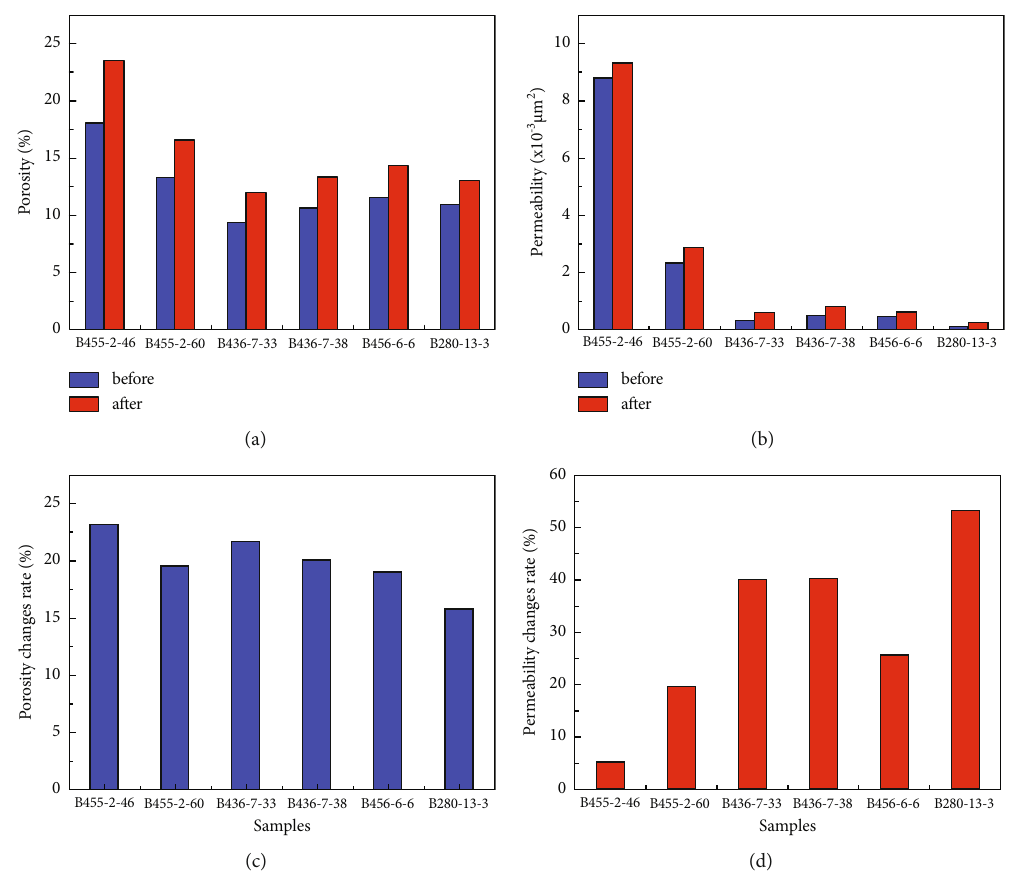
Figure 7: Changes of reservoir porosity and permeability before and after Soxhlet extraction. (a) Porosity changes. (b) Permeability changes. (c) Porosity change rate. (d) Permeability change rate.